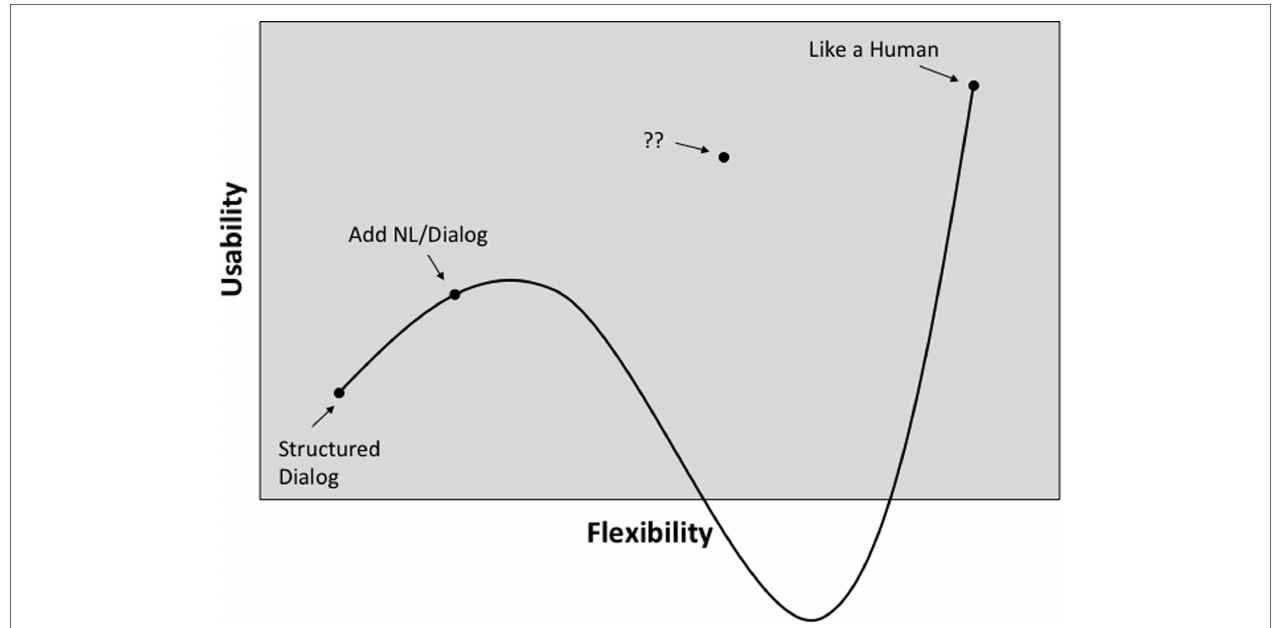
FIGURE 15 | Illustration of the consequences of increasing the flexibility of spoken language dialog systems; increasing flexibility can lead to a habitability gap where usability drops catastrophically (reproduced, with permission, from Phillips (2006)). This means that it is surprisingly difficult to deliver a technology corresponding to the point marked ‘??’. (Contemporary systems such as Siri or Alexa correspond to the point marked ‘Add